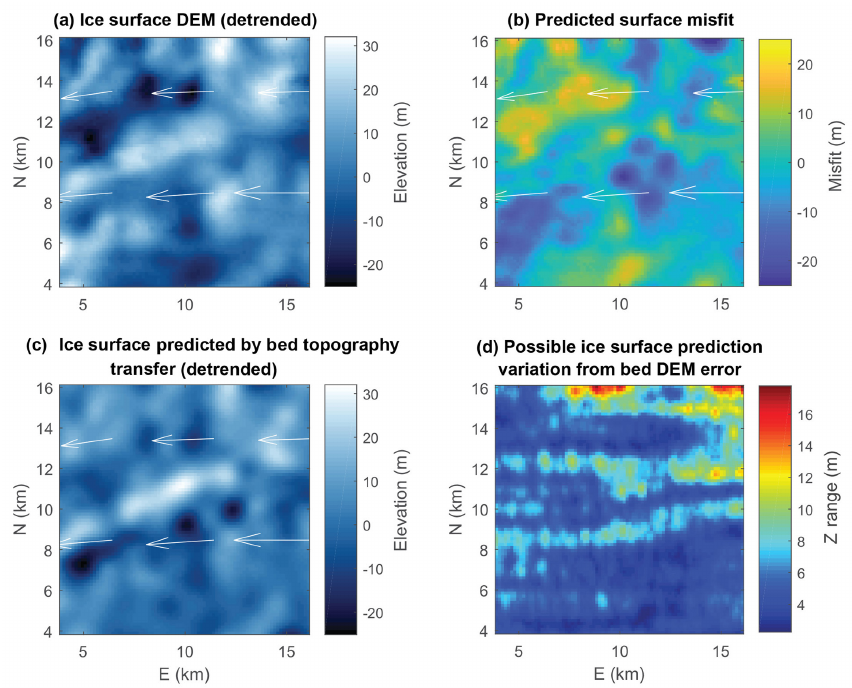
Figure 8. Example ice surface prediction and error analysis from study region R1 (Fig. 1a, Table 1). (a) Detrended ice surface DEM. (b) Detrended ice surface predicted with bed topography transfer, with η = 10 14 Pas and C 0 ∗ = 10. We note that kilometer-scale depressions and ridges–peaks are generally configured similarly to the real ice surface DEM in (a) and that topographic relief also corresponds well. (c) Prediction misfit (subtraction between the actual and predicted ice surfaces in a and b ). Prediction misfit is often significant (mean misfit in this region is 13.3% of the regional topographic relief), which might be expected for a number of reasons discussed in Sect. 2.1, 2.3.1, and 2.3.2. (d) Potential effects of bed DEM error on ice surface predictions (see error map in Fig. 2a). Bed DEM error is less than ∼ 60m and the potential surface prediction variation is much less than the amplitude of surface topography. White arrows in all plots indicate ice surface velocity field, and the bed DEM underlying this region is shown in Fig.